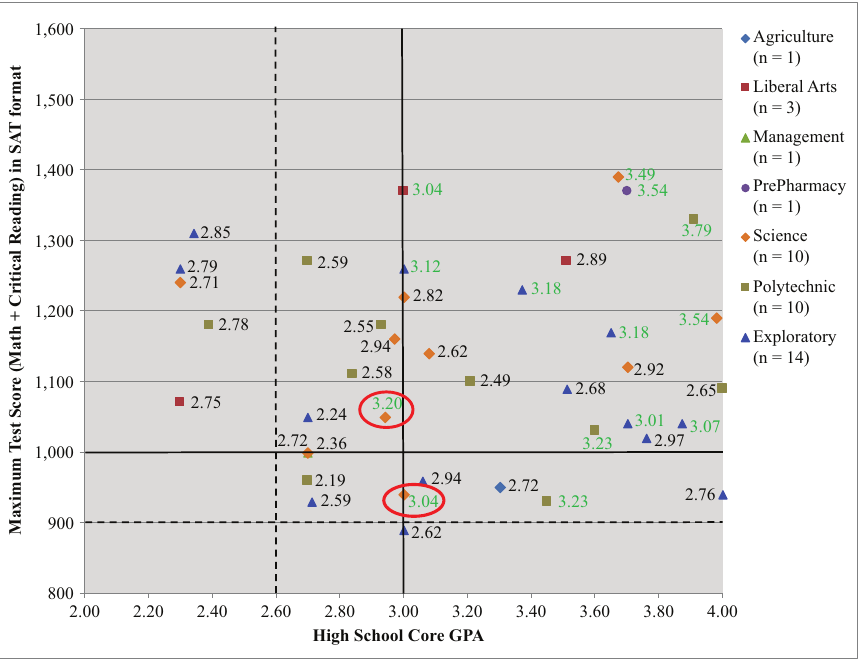
Fig. 4. Graduation GPAs of change of degree objective students earning a Bachelor of Science in Engineering at Purdue University plotted against high school core GPA and maximum equivalent test score: